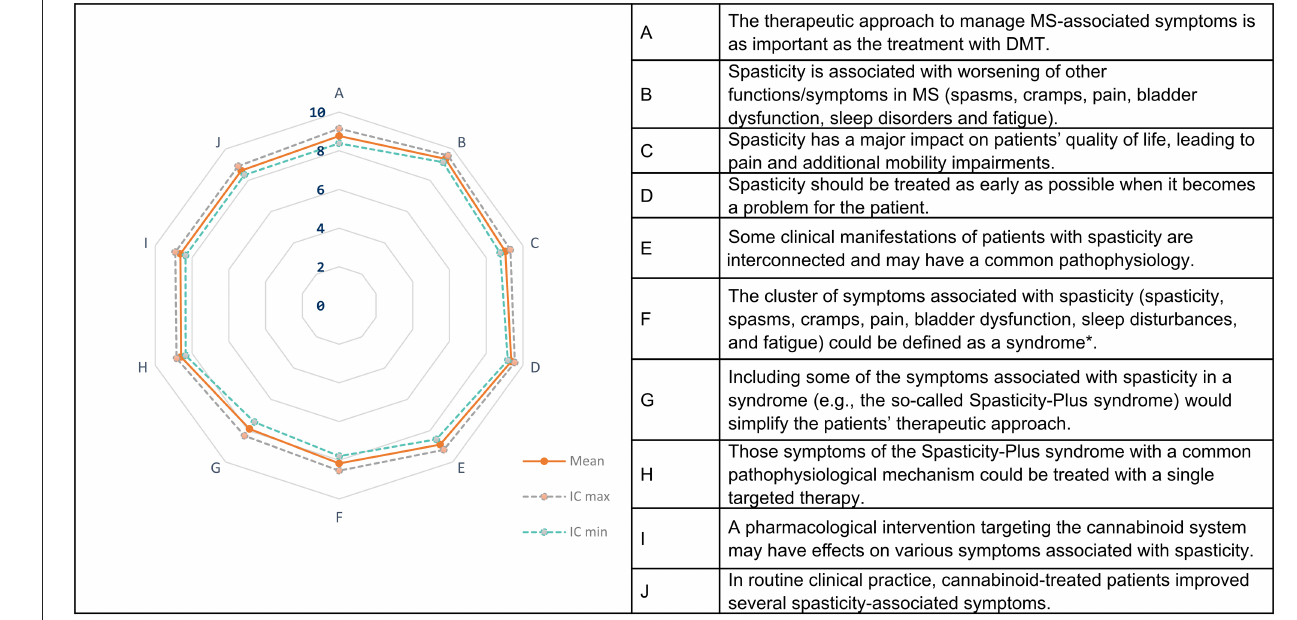
FIGURE 3 | Spasticity-Plus syndrome concept. The spider map shows the mean scores (95% confidence interval) for each statement scored on a 10- point scale (0 = totally disagree, 10 = totally agree). MS, multiple sclerosis; DMT, disease-modifying treatment. * Syndrome is defined as a combination of signs and/or symptoms that form a distinct clinical entity indicative of a disease or disorder.